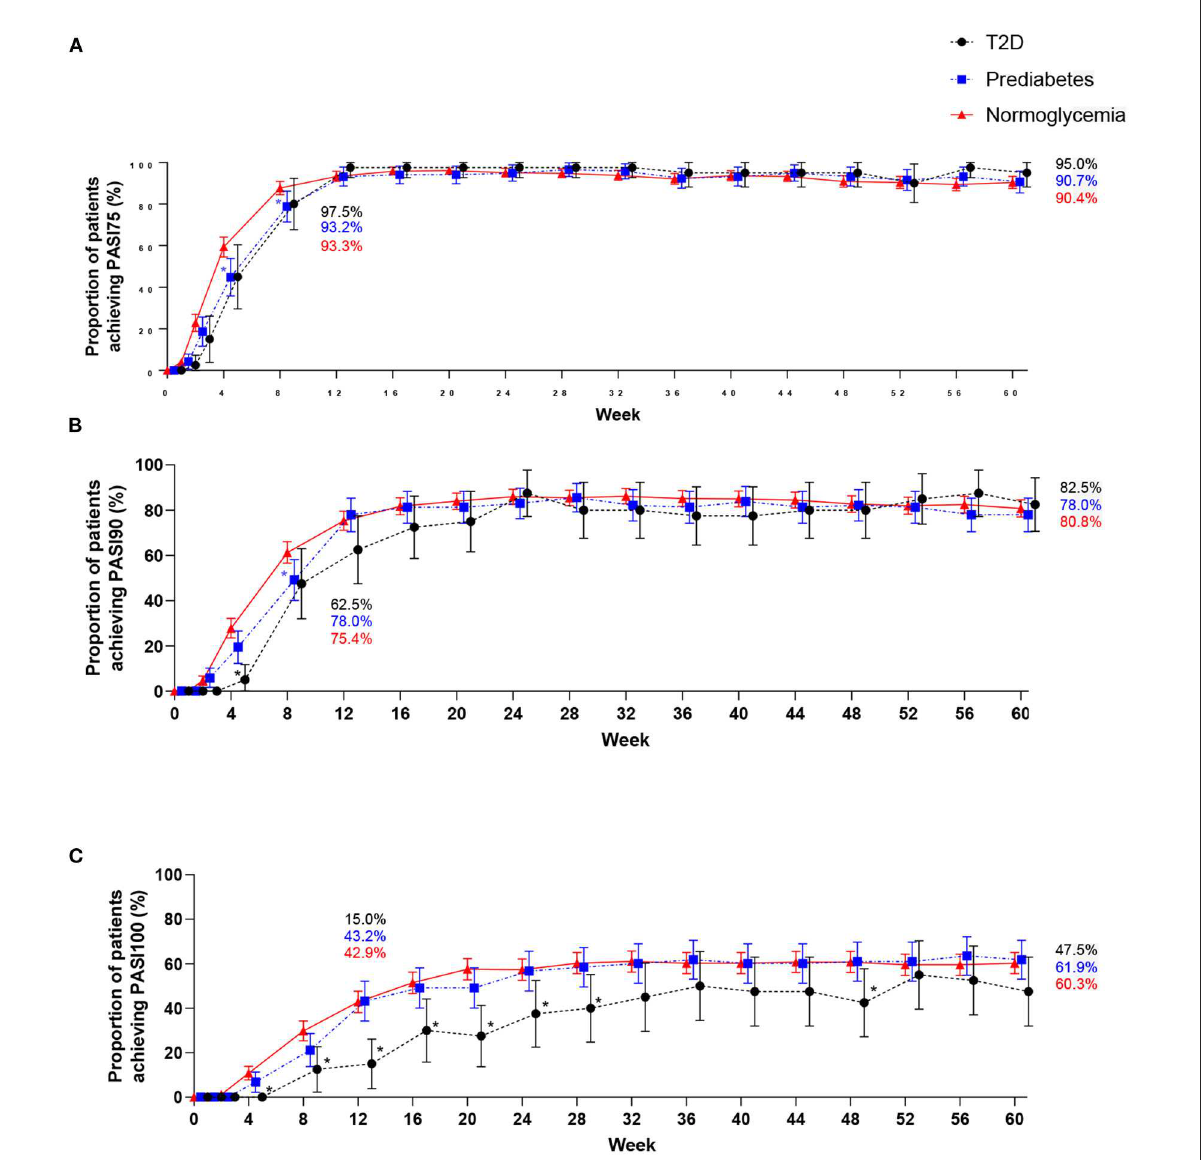
FIGURE1 PASI outcomes through Week 60 (NRI). Percentage of patients with type 2 diabetes, prediabetes, and without type 2 diabetes or prediabetes (normoglycemia) achieving PASI75 (A) , PASI90 (B) , and PASI100 (C) . n, number; PASI, Psoriasis Area and Severity Index; T2D, type 2 diabetes. Symbols in line graphs are offset horizontally to differentiate overlapping data points. 95% confidence intervals are shown. * indicates p < 0.05, T2D vs. normoglycemia, * indicates p < 0.05, prediabetes vs.